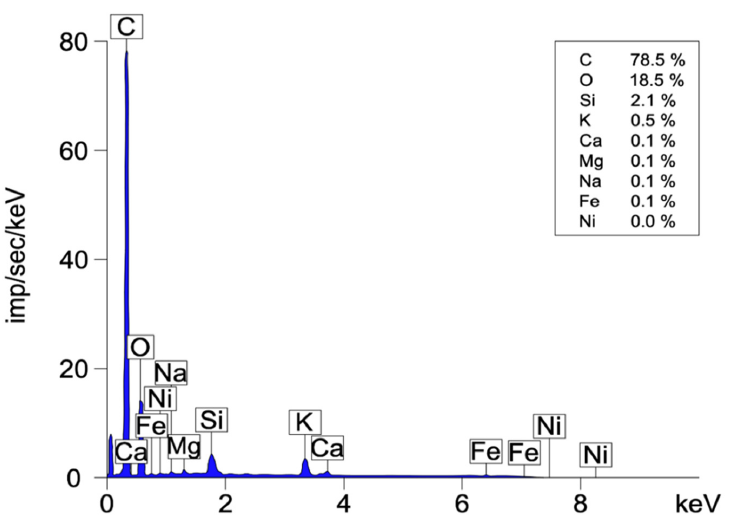
Figure 6. EDX spectrum of rice straw biochar samples.